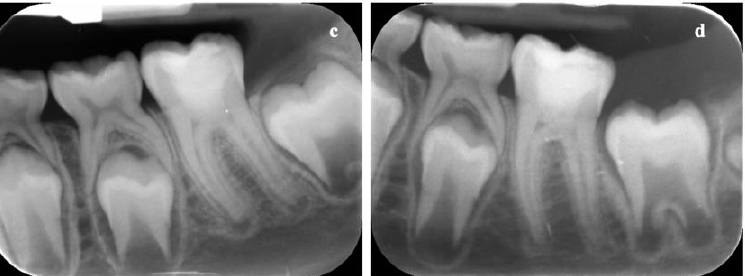
Figure 10. Periapical radiographs of the dental element (3.6) treated with Biodentine. The immature